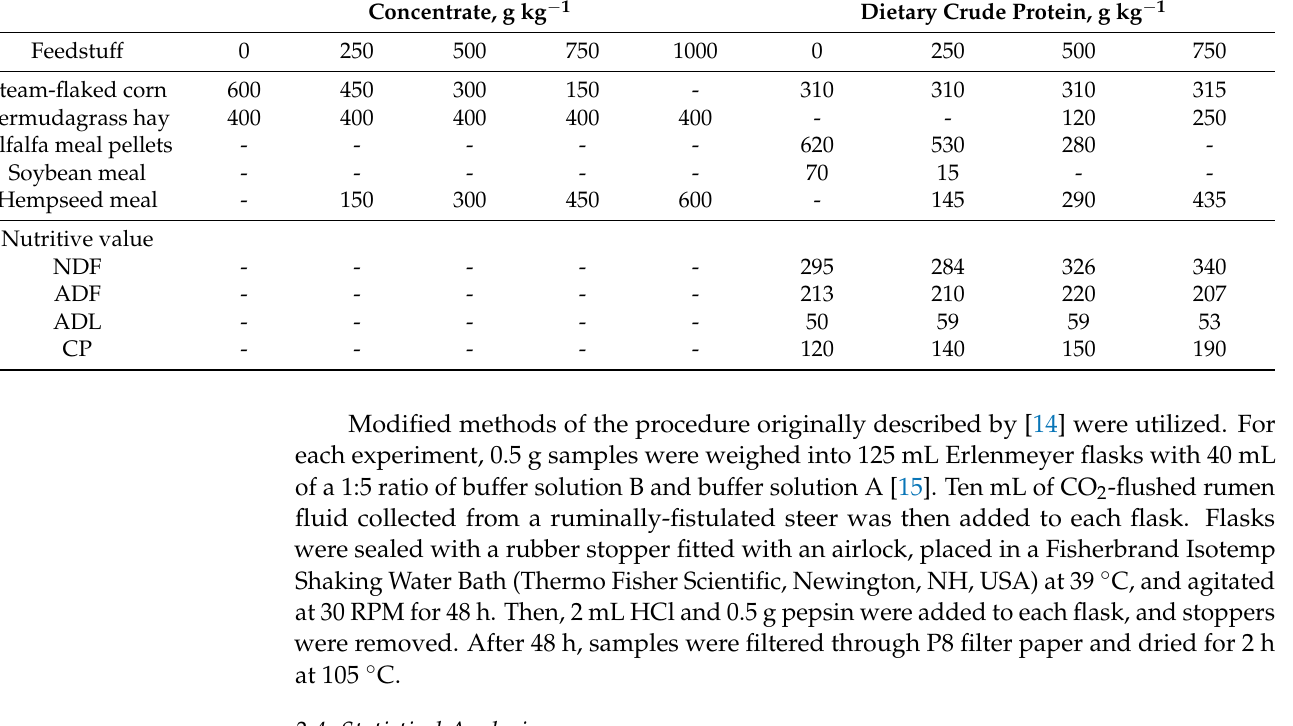
Table 1. Composition (g kg − 1 ) of feed mixtures tested in the in vitro experiments of hempseed meal digestibility. Experiment 1: Hempseed Meal Replacement of Experiment 2: Hempseed Meal Replacement